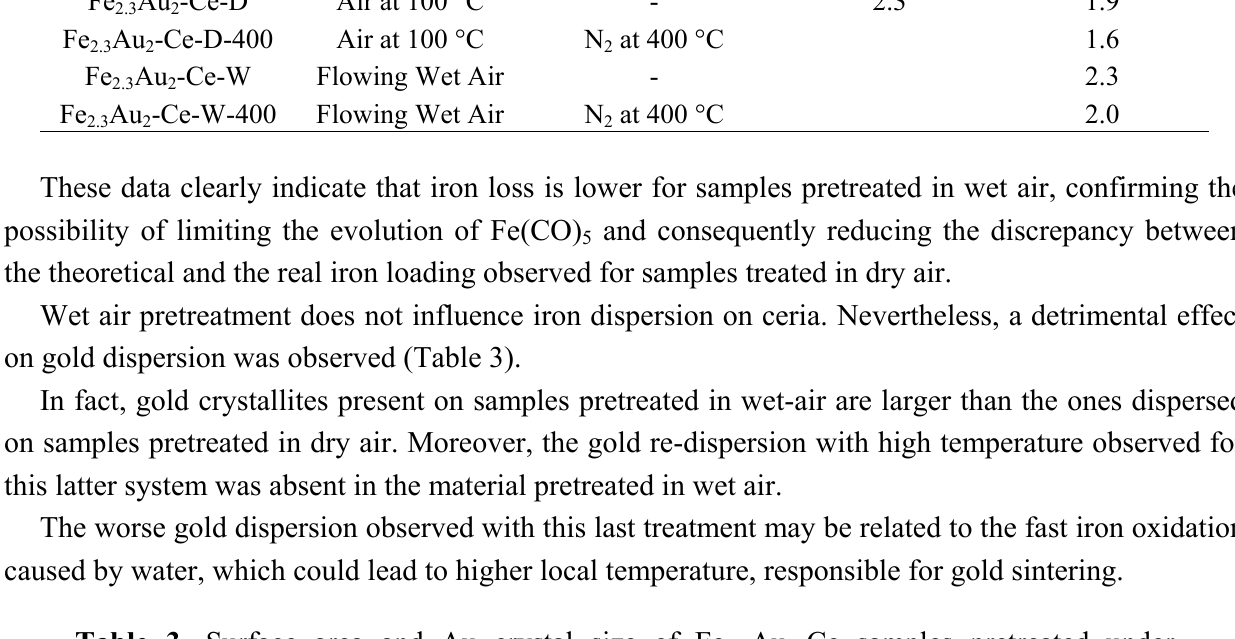
Au -Ce samples pretreated under 2.3 2